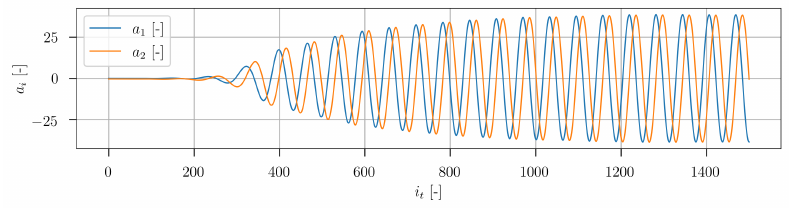
Figure 6. First three POD modes from the cylinder case. Top: 1st mode, middle: 2nd mode, bottom: 3rd mode.